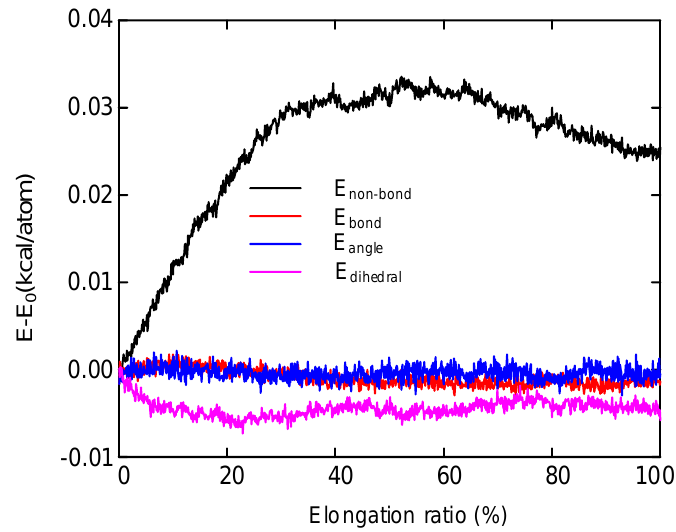
Figure 14. Energy decomposition for the mixture polyethylene structure.